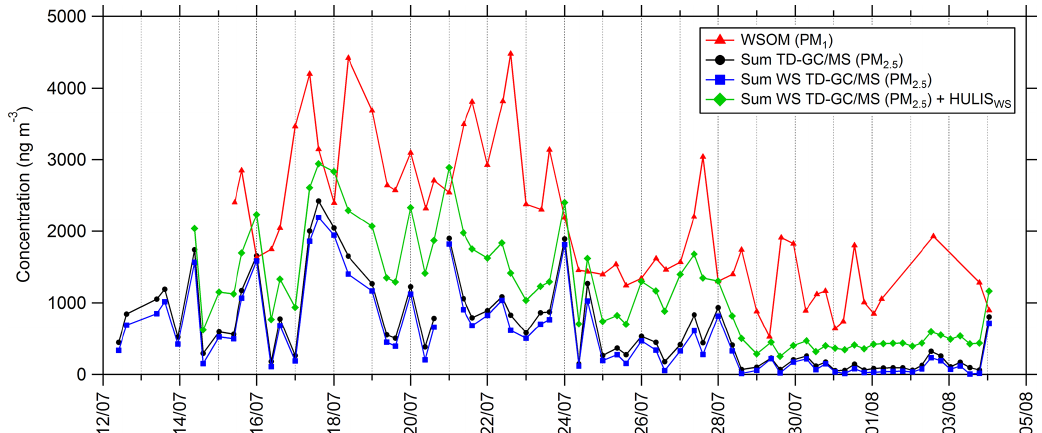
Figure 10. Time series of PM 1 water-soluble organic matter (WSOM; red line), total sum of PM 2 . 5 measured by TD–GC–MS (black line), total sum of compounds measured by TD–GC–MS and having Henry’s law constant higher than 10 4 Matm − 1 measured by TD–GC–MS (water-soluble TD–GC–MS; blue line), and total sum of water-soluble compounds measured by TD–GC–MS and water-soluble HULISs (green line).